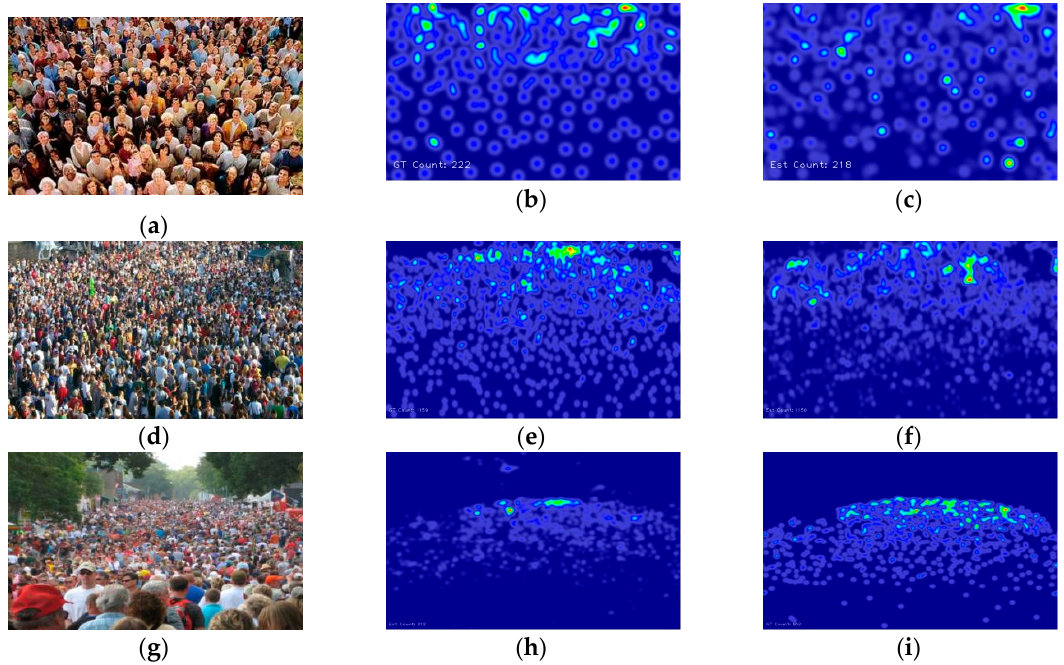
Figure 5. Samples for density map for crowd counting. ( a , d and g ) are original image. ( b , e and h ) are density map for ground truth, ( c , f and i ) are density map of Deep Scale-Adaptive Convolutional Neural Network (DSA-CNN).